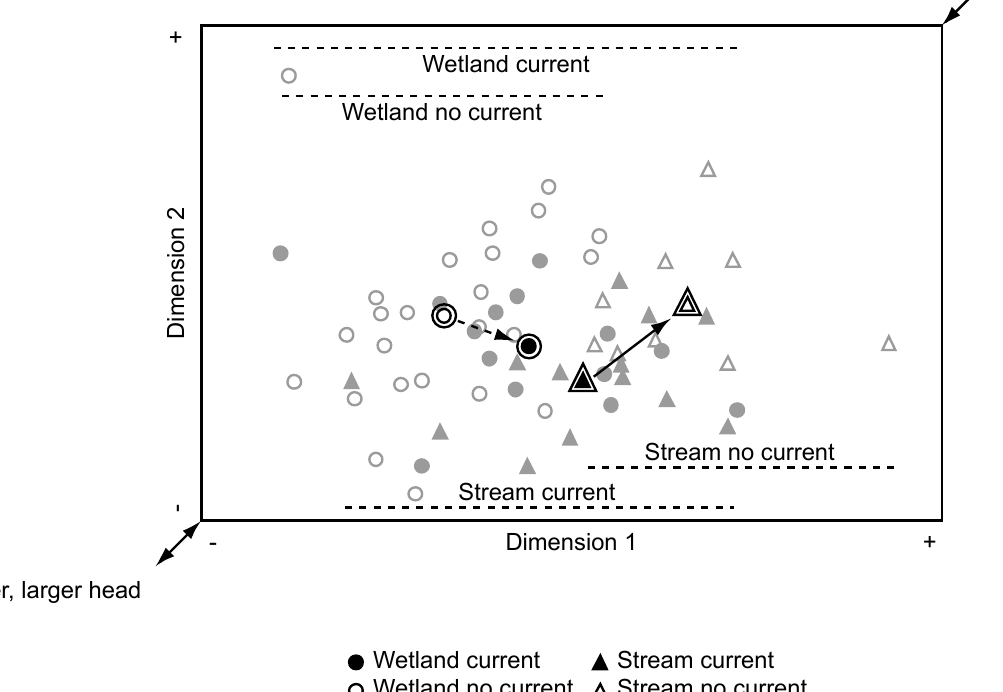
Figure 2. Captive head Multi Dimensional Scaling (MDS) ordination of nineteen mean relativised standard length standardised morphological variables for G. gollumoides individuals within the four experimental treatments. Descriptors are interpreted from Spearman ρ correlations of morphological variables and dimension scores significant at p < 0.05 (Table 2). Arrows indicate negative and positive directions across dimensions. Diagonal arrows indicate significant correlations of variables with both dimensions. Spread across dimension 1 for each treatment is given by dashed lines. Black outlined symbols are centroids for each treatment with arrows indicating direction of shifts between source treatment and the reciprocal. Grey symbols following the same convention as the centroids represent each individual G. gollumoides for each treatment.